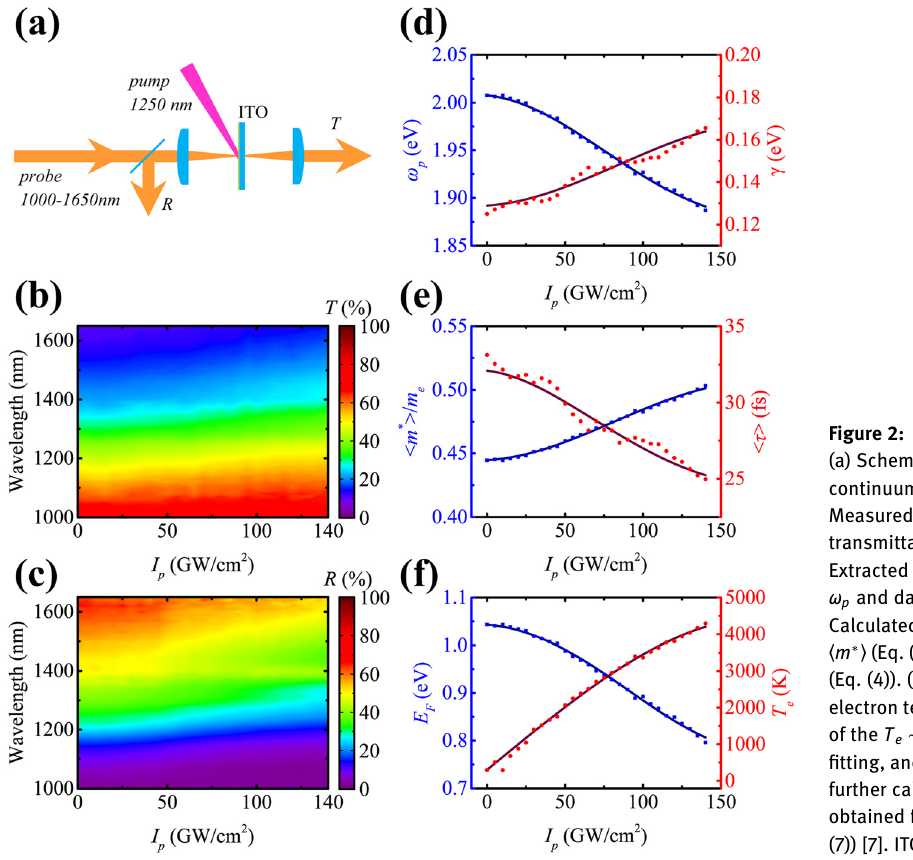
Figure 2: Experimental results. (a) Schematic of the femtosecond-pump continuum-probe experimental setup. Measured spectra of I p -dependent transmittance T (b) and re fl ectance R (c). (d) Extracted I p -dependent plasma frequency ω p and damping factor γ (Eq. (7)).